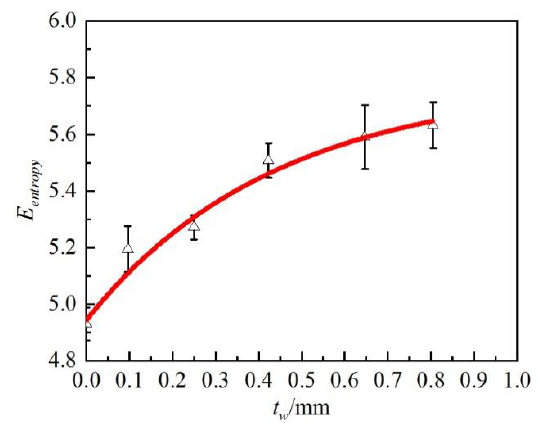
Figure 4. Relationship between the information entropy value and corrosion depth.